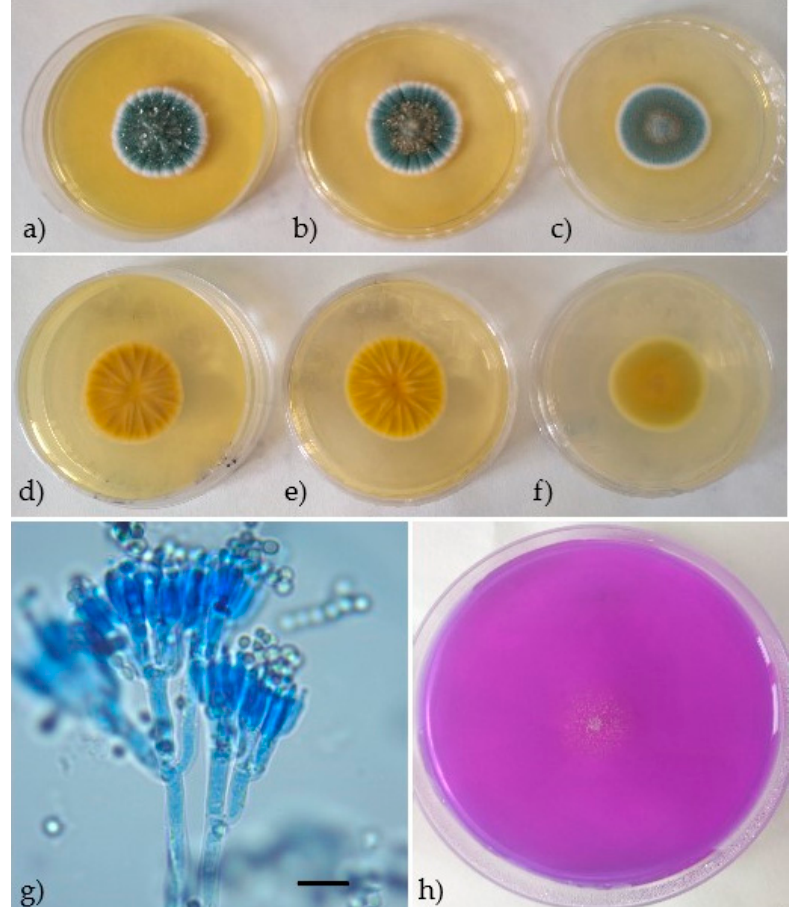
Figure 1. Penicillium verrucosum. Seven-day-old colonies on Malt Extract Agar (MEA) ( a )